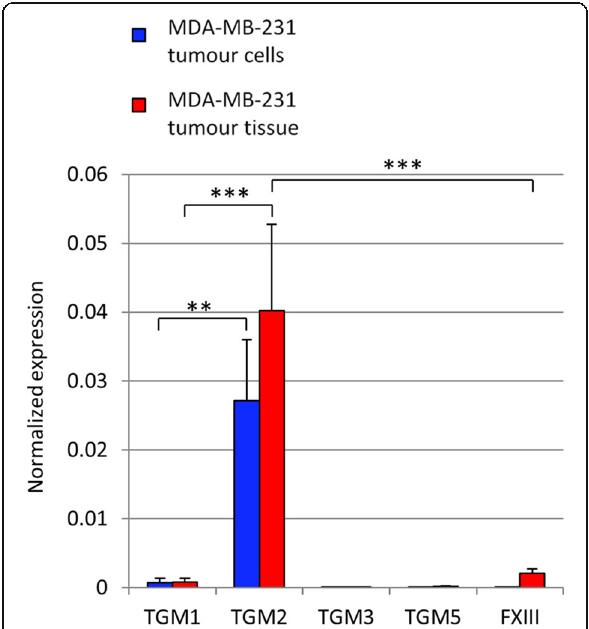
Fig. 2 Transglutaminase mRNA expression in MDA-MB-231 tumour cells and in MDA-MB-231 tumour tissue. Results are expressed as relative values to GAPDH mRNA expression±standard deviation ( n =4; ** p <0.005; *** p